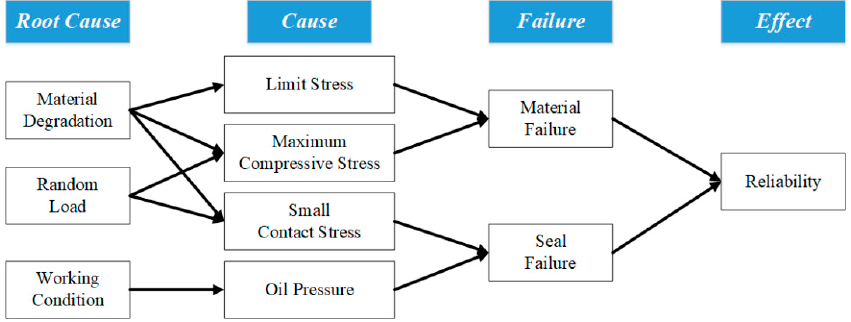
Figure 2. Factors that affect reliability.